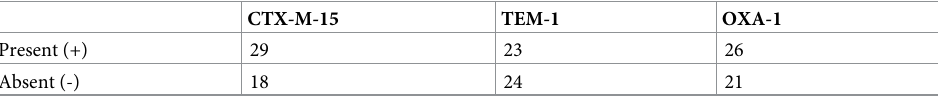
Table 5. Presence of CTX-M-15, TEM-1, and OXA-1 resistance genes. The frequency of resistance genes CTX-M- 15, TEM-1, and OXA-1 in our 47